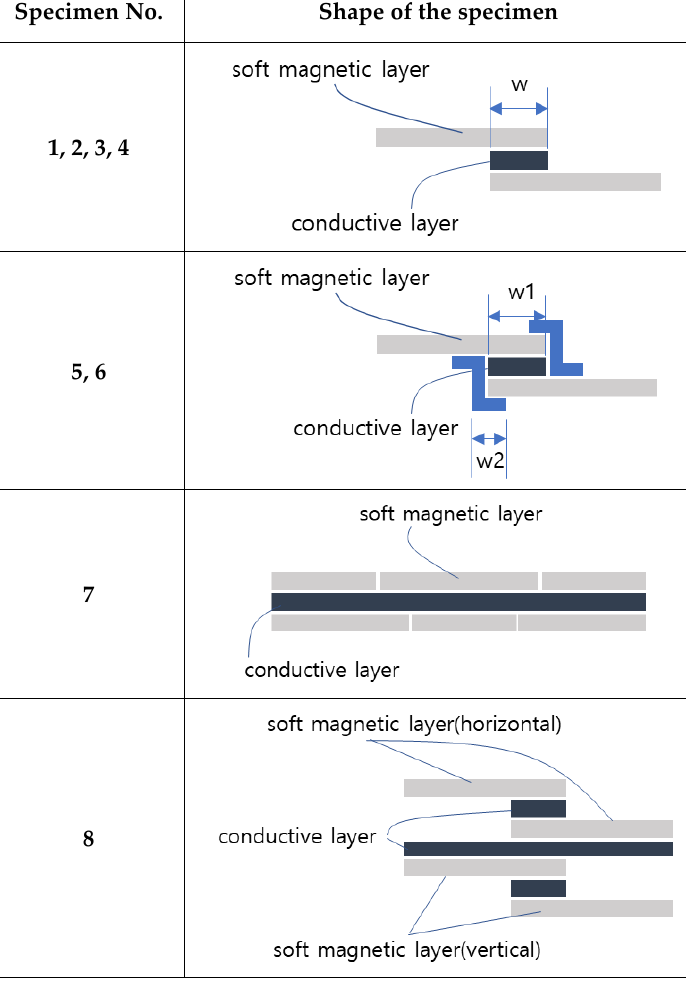
Figure 2. Shape of the specimen.